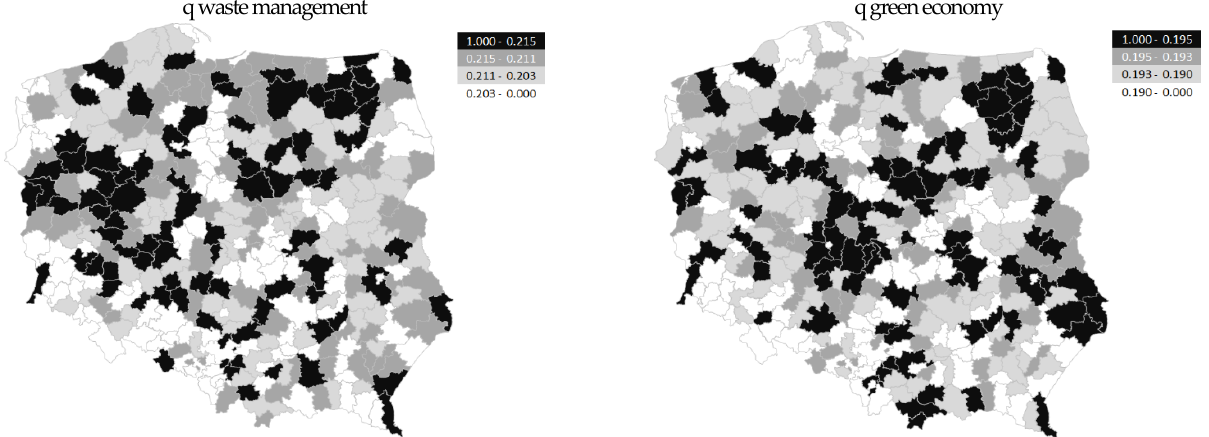
Figure 9. Concentration of the synthetic measure, waste management and green economy of districts (index Gini, for 2010–2020). Source: own study based on the BDL CSO data.